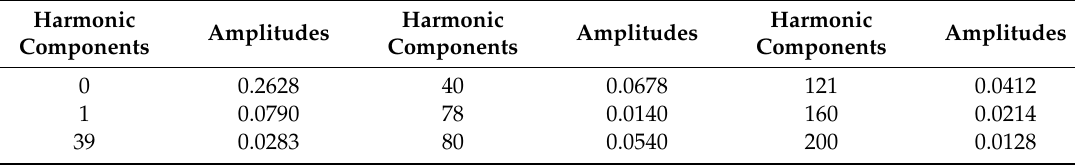
Figure 9. Transmission error spectrum. Table 4. Harmonic components of the transmission